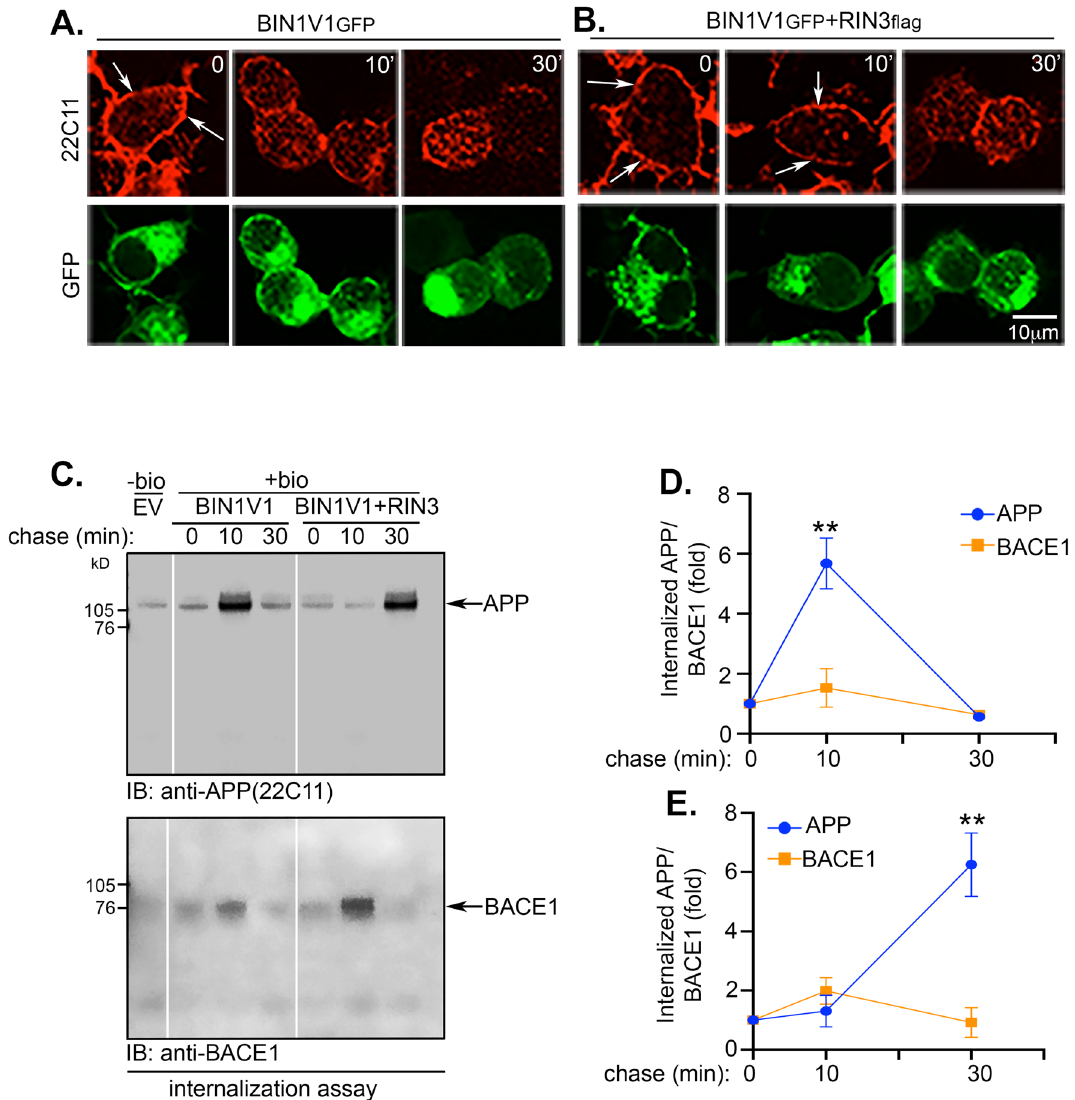
Figure 3. Co-expression of RIN3 with the neuronal isoform BIN1V1 delays cell surface endocytosis of APP. ( A) and ( B) Confocal images of N2A APP cells overexpressing BIN1V1 GFP or BIN1V1 GFP + RIN3 flag labeled with 22C11 at 4 °C for 1 h to allow labeling cell surface APP followed by endocytosis at 37 °C for 0, 10 and 30 min as before. Loss of cell surface APP (arrows) suggested endocytosis. Representative images of approximately 20 cells per experiment performed in duplicates. ( C) Representative Western blot images of internalized biotinylated APP (IB:22C11) or BACE1 (anti-BACE1) after 0-, 10- and 30-min chase of N2A APP cells overexpressing BIN1V1 GFP or BIN1V1 GFP + RIN3 flag . ( D) and ( E) Graphs are quantitation of internalized biotinylated APP (blue circles) or BACE1 (orange squares) after 0-, 10- and 30-min chase of cells overexpressing BIN1V1 GFP ( D ) or BIN1V1 GFP + RIN3 flag ( E ). Error bars represented ± SEM from three independent experiments. n = 3, Two-way ANOVA statistical analysis provides ** p <